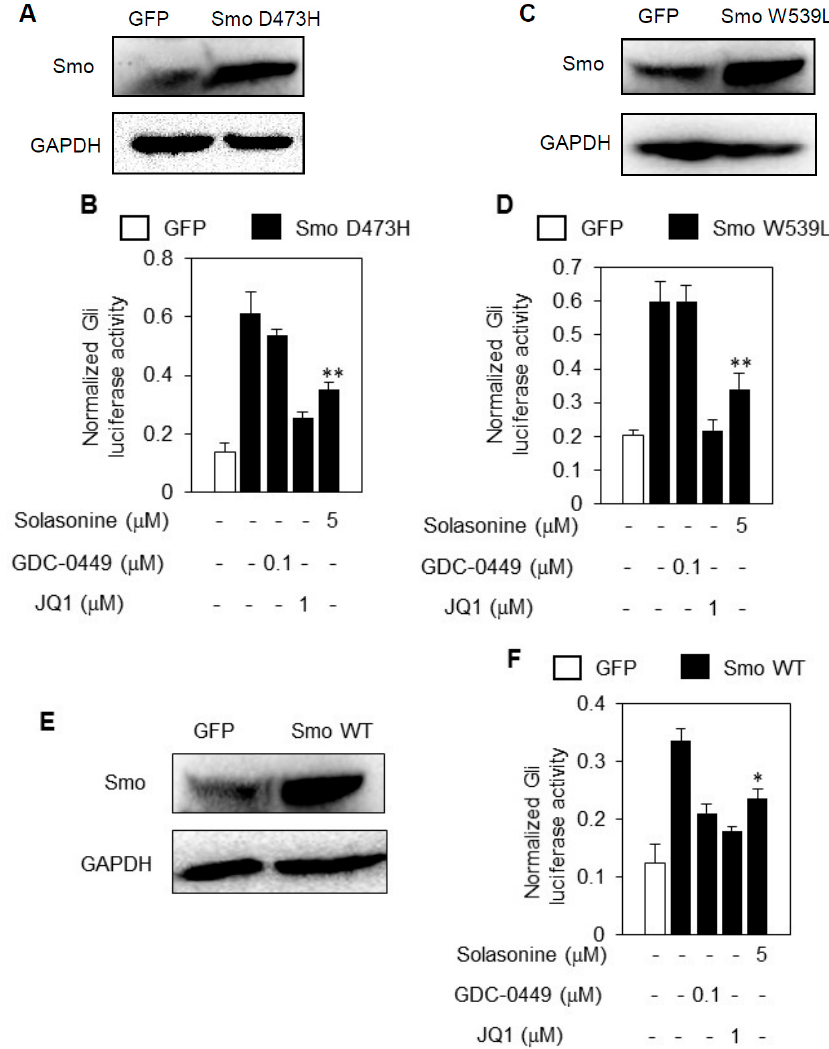
Figure 5. Solasonine inhibits the Hh pathway activity provoked by ectopic expressions of distinct Smo plasmids. ( A ) Ectopic expression of SmoD473H in light II cells as examined by western blot analysis; ( B ) Solasonine suppressed the Gli-luciferase activity provoked by exogenous SmoD473H. Light II cells transfected with GFP and SmoD473H plasmids were exposed to various treatments as indicated for 36 h. Data are expressed as mean ± s.d. ( n = 3); ( C ) Ectopic expression of SmoW539L in light II cells as examined by western blot analysis; ( D ) Solasonine suppressed the Gli-luciferase activity provoked by artificially forced expression of SmoW539L. Light II cells transfected with GFP and SmoW539L plasmids were subjected to various treatments as indicated for 36 h. Data are expressed as mean ± s.d. ( n = 3); ( E ) Ectopic expression of Smo wild type in light II cells as examined by western blot analysis; ( F ) Solasonine blocked the Gli-luciferase activity stimulated by artificially forced expression of Smo wild type. Light II cells transfected with GFP and Smo wild type plasmids were subjected to various treatments as indicated for 36 h. Data are expressed as mean ± s.d. ( n = 3). Statistical differences were analyzed by the two-tailed Student (cid:48) s t test and p < 0.05 was considered as significant (* p < 0.05; ** p <